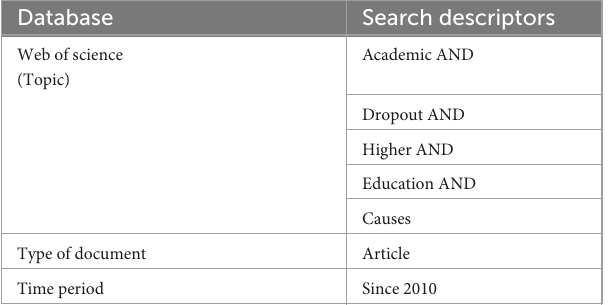
TABLE 4 Search strategy in the Web of Science database.